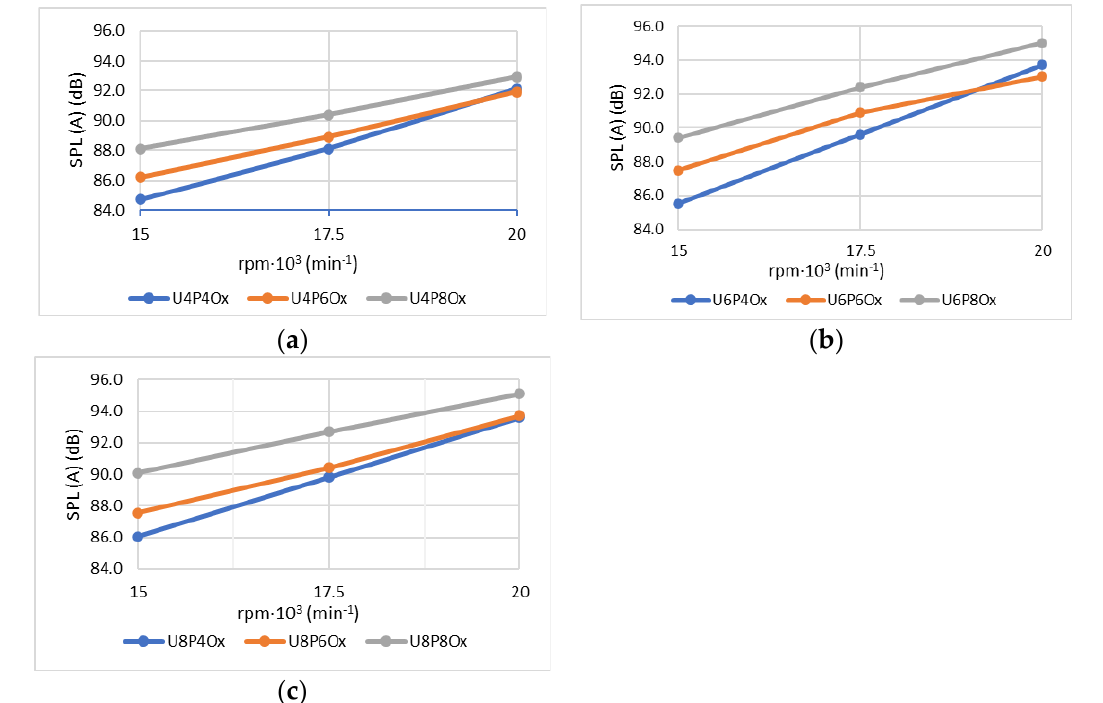
Figure 4. Dependence of sound pressure level (SPL) on change in revolutions, feed speed, and radial depth of cut (( a ) — radial depth of cut 4 mm, ( b ) — radial depth of cut 6 mm, ( c ) — radial depth of cut 8 mm).